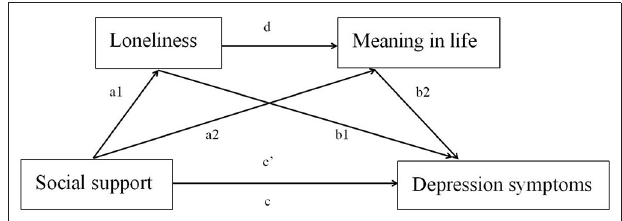
FIGURE 1 | Roadmap of the influence of social support on depressive